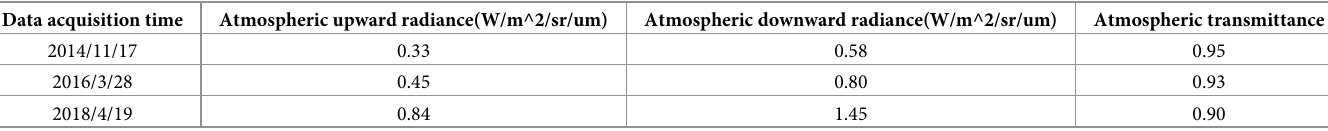
Table 3. Results of atmospheric parameters of remote sensing images in each